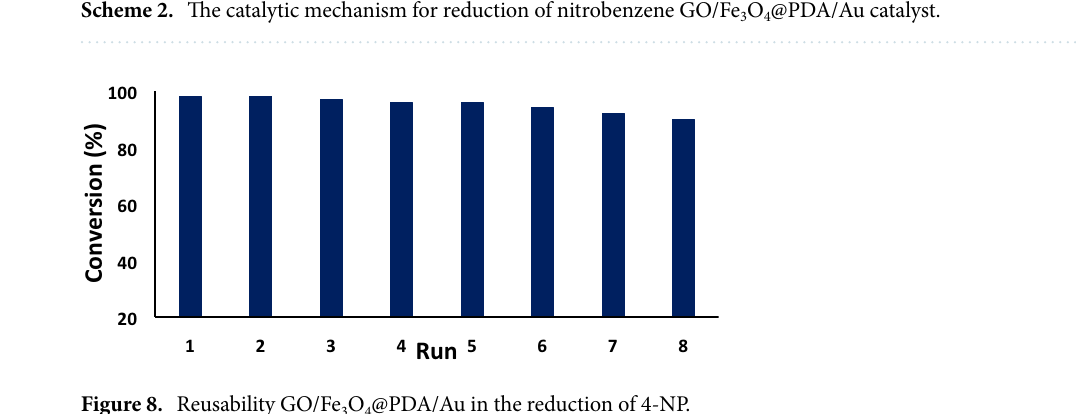
Figure 8. Reusability GO/Fe 3 O 4 @PDA/Au in the reduction of